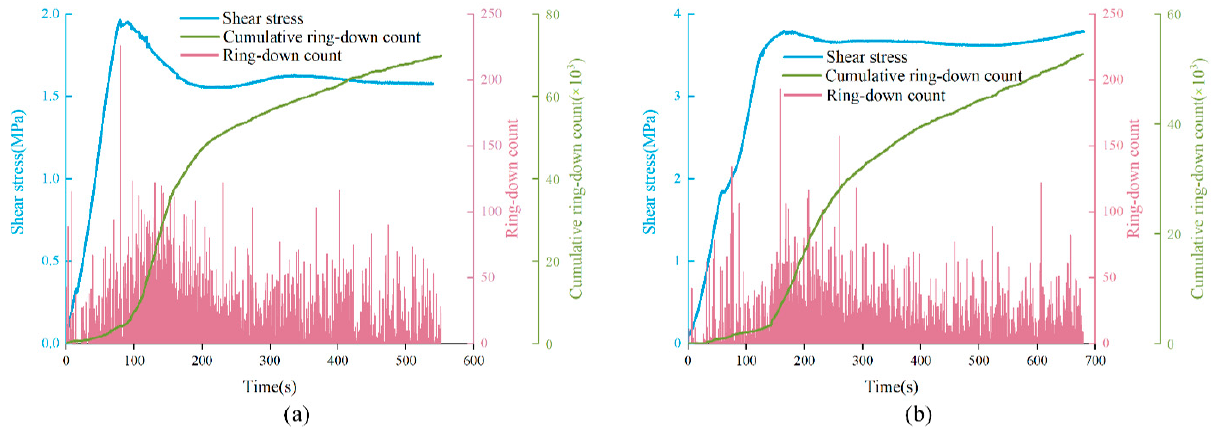
Figure 11. The variation trend of ring-down count and shear stress with time: ( a ) DS-02-30-2, ( b )